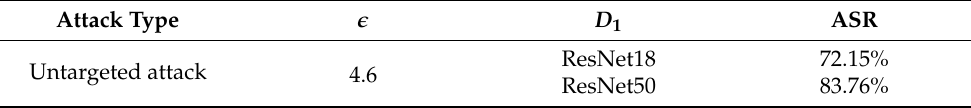
Table 8. Attack results under l 2 norm on